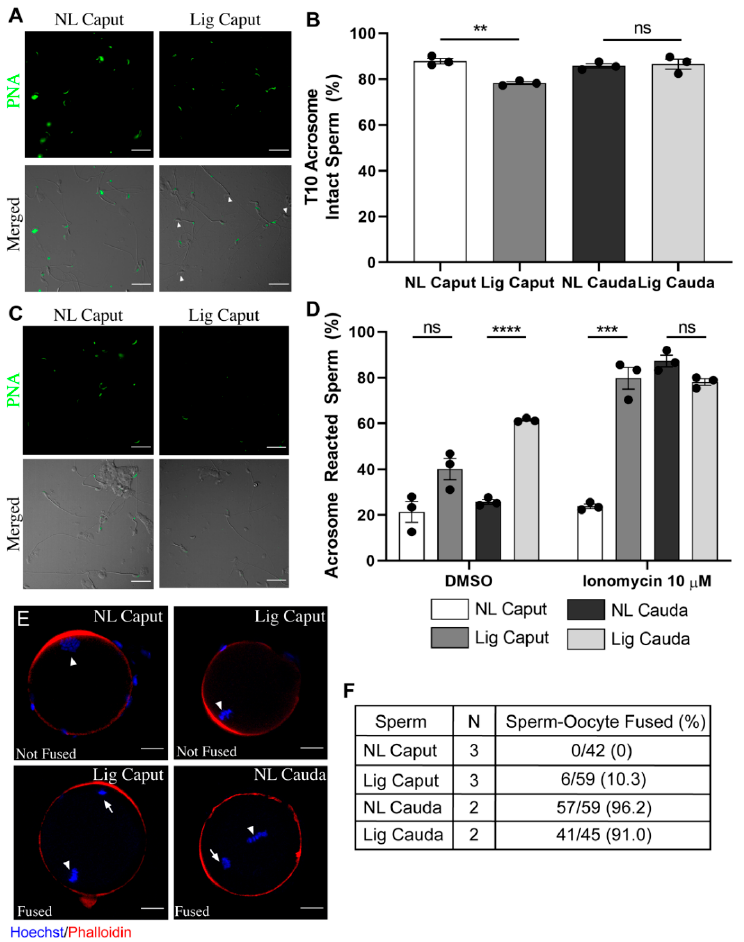
Figure 6. Effects of epididymal ligation on acrosome reaction and fusion. Sperm samples were re- covered from each experimental region 7-days post-ligation surgery and placed into capacitation media. ( A ) Analysis of acrosomal status. Representative microscopy images of acrosomal status (PNA, green, upper panel) of NL Caput and Lig Caput after 10 min of capacitation (DIC, merged with PNA, lower panel). Scale bars: 10 µm. ( B ) Quantification of acrosome intact sperm at 10 min of capacitation. Independent experiments n = 3, individual sperm counted: NL Caput = 337, Lig Caput = 324, NL Cauda = 289, Lig Cauda = 256. ( C ) Analysis of acrosome reaction. After 60 min of capaci- tation, sperm samples were incubated with either DMSO or Ionomycin (10 µM) for 30 min to assess ability to acrosome react (as described in methods). Representative microscopy images of acrosome status (PNA, green, upper panel) of NL Caput and Lig Caput after incubation with ionomycin and DIC images merged with PNA fluorescence (lower panel). Scale bars: 10 µm. ( D ) Quantification of acrosome reacted sperm after incubation with either DMSO or Ionomycin. Independent experi- ments n = 3, individual sperm counted for each condition: NL Caput = 380, Lig Caput = 370, NL Cauda = 325, Lig Cauda = 390. ( E ) Capacitated sperm samples were co-incubated with zona-free MII oocytes for 60 min, followed by fixing and evaluation of fusion (as described in methods). Repre- sentative confocal microscopy images of Lig Caput (fused and not fused), NL Caput (not fused) and NL Cauda (fused) prospective zygotes co-stained with Phalloidin (red) to mark the subcortical actin cytoskeleton and Hoechst (blue) to mark female/male DNA. Arrowhead: female DNA, Arrow: male DNA. Scale bars: 25 µm. ( F ) Table depicting fusion assay results from all experimental conditions. Statistical significance comparing NL Caput vs. Lig Caput and NL Cauda vs. Lig Cauda using an unpaired t -test in all graphs indicated; ns p > 0.05, ** p < 0.01, *** p < 0.001, **** p < 0.0001.